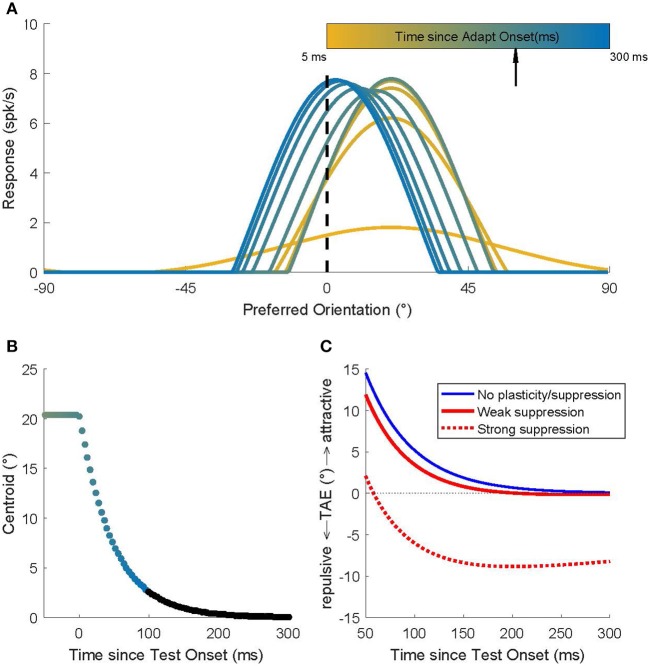
Recurrent network model simulations of an adaptation protocol in which a 20° adapter was followed by a 0° test. (A) Population activity dynamics in a model without plasticity. Color indicates progression over time. The earliest pattern (orange) represents the activity at the start (t = 5 ms) of the adaptation phase; the hill of activity is broad but, due to the recurrent connections, it gradually narrows around the neurons that prefer 20°. After 200 ms (black arrow) the 0° test stimulus is presented and the hill of activity gradually moves to position itself around the neurons that prefer 0°. (B) The dynamics of the location of the hill of population activity (here represented by its centroid). In the adaptation phase (t < 0 ms), the hill is centered on 20°. Once the 0° test is presented, the hill moves toward 0°, but this takes a surprisingly long time (Quiroga et al., 2016). Colors match those used to represent time in (A). Time points omitted for clarity from (A) are shown here in black. (C) Predicted TAE in three models. One model (blue curve) has no plasticity and its tuning curve shifts are the consequence of the recurrent network dynamics alone. The other two models include the effect of spike rate suppression that occurs for prolonged (seconds) adapter presentations (red dashed curve; strong suppression) or for brief adapter presentations (red solid curve; weak suppression). These modeling results predict that the common long-term adaptation protocols should evoke the well-documented repulsive TAE, while an adaptation protocol that isolates (or emphasizes) the contribution of short-term effects should result in an attractive TAE.